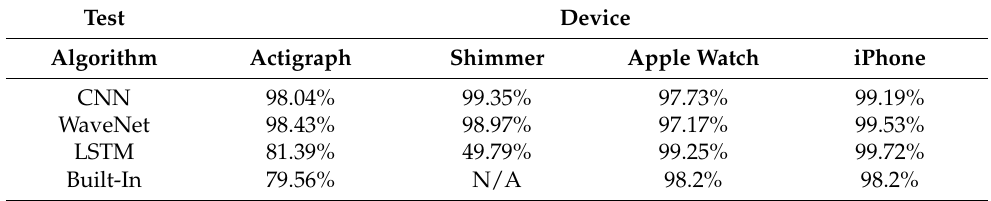
Figure 10. Results of testing the personalized models on an independent dataset using raw accelera- tion. Each dot corresponds to one subject (blue dots indicate data in [38]). Table 3. Step-count accuracy of personalized models on independent dataset using raw